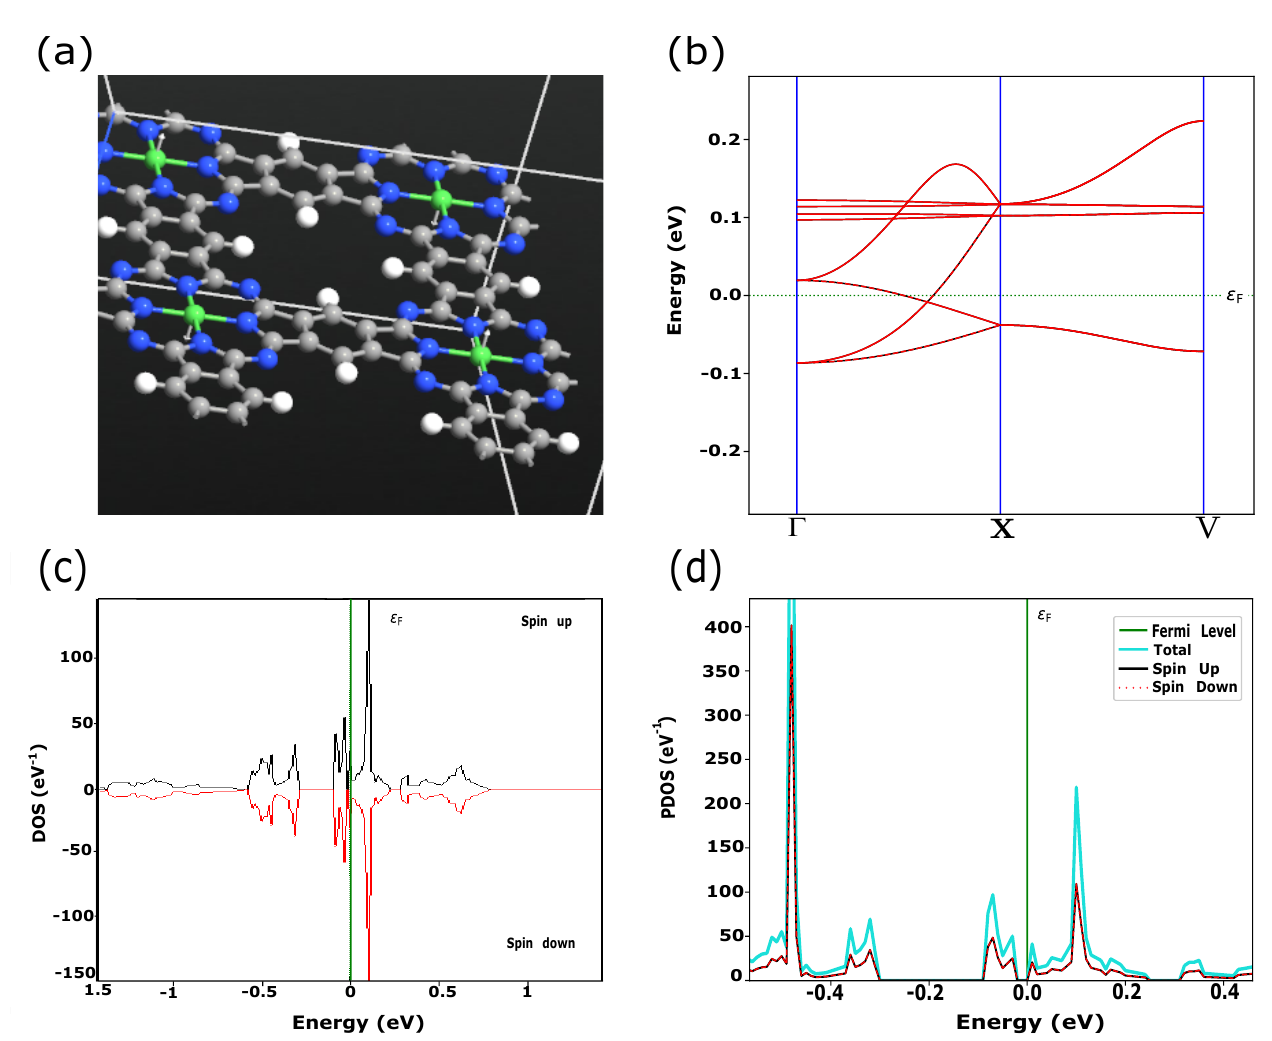
Figure 4. ( a ) NiPPC with magnetic moments (white arrows) aligned in anti-parallel configuration, determined as AFM in the text; ( b ) Dispersion bands; ( c , d ) DOS and PDOS depicting the weak metallic behavior.